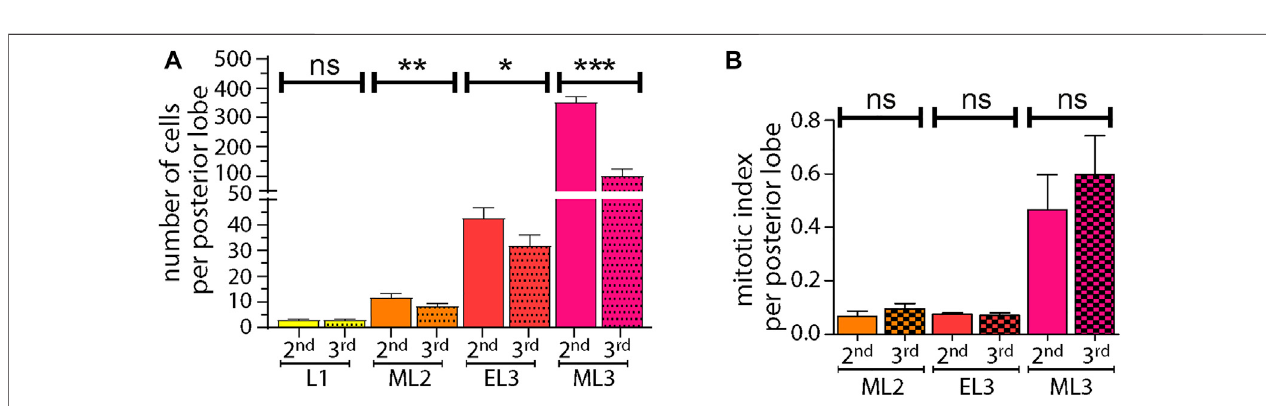
FIGURE 4 | Posterior lobe growth during larval development. (A) Quanti fi cations of posterior lobe cell numbers during larval development. * p < 0,1; ** p < 0.001,*** p < 0.001 and ns (not signi fi cant). (B) Quanti fi cations of mitotic index in posterior lobes during larval development.